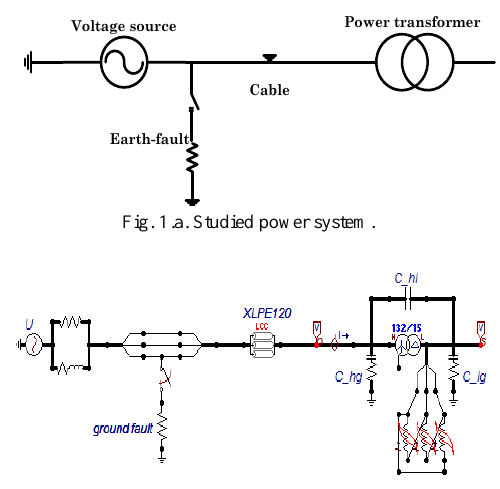
Fig 1.b. ATP Draw circuit for